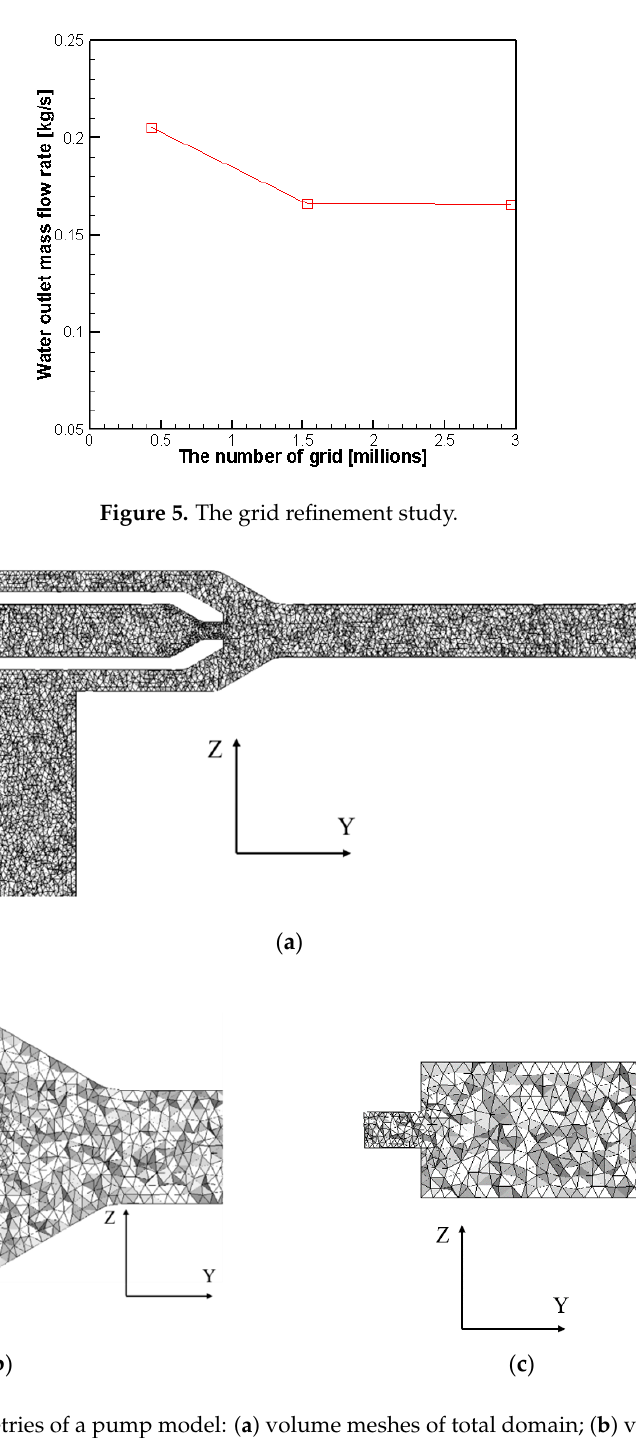
Figure 5. The grid refinement study. Table 2. Cases and their boundary conditions.